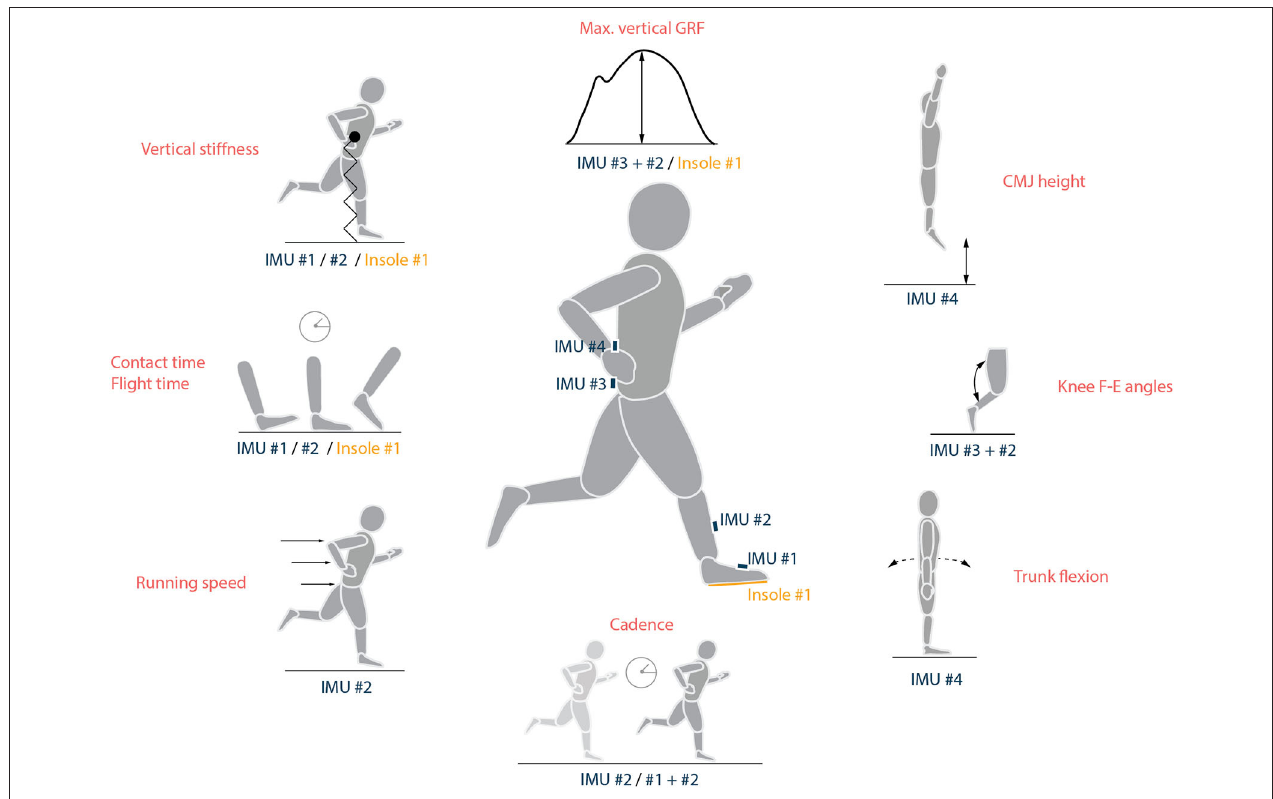
FIGURE 5 | Parameters that show a consistent trend in response to acute fatigue and a potential wearable sensor setup to measure them. Stride length can be estimated by multiplying running speed and gait cycle time for each stride, while tibial acceleration can be measured directly from IMU#2. IMU, inertial measurement